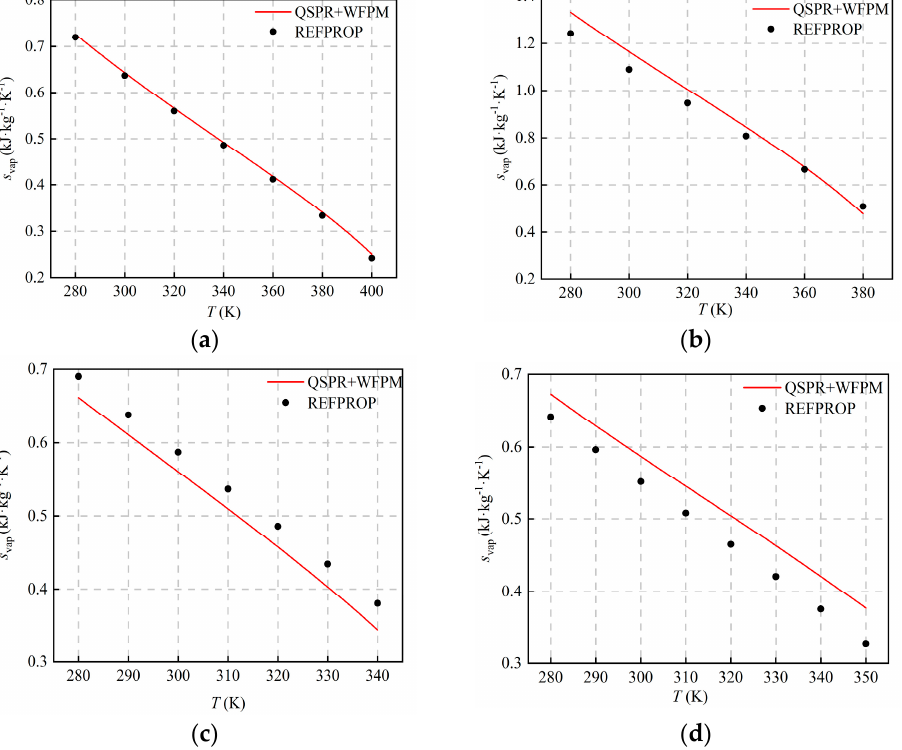
Figure 5. Comparison of h vap at different temperatures: ( a ) R245fa; ( b ) R600a; ( c ) R134a; ( d ) R1234ze(E).